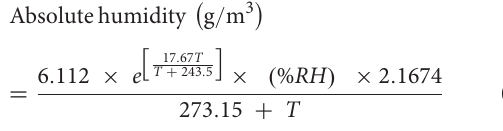
%RH and temperature as follows (Hall et al.,